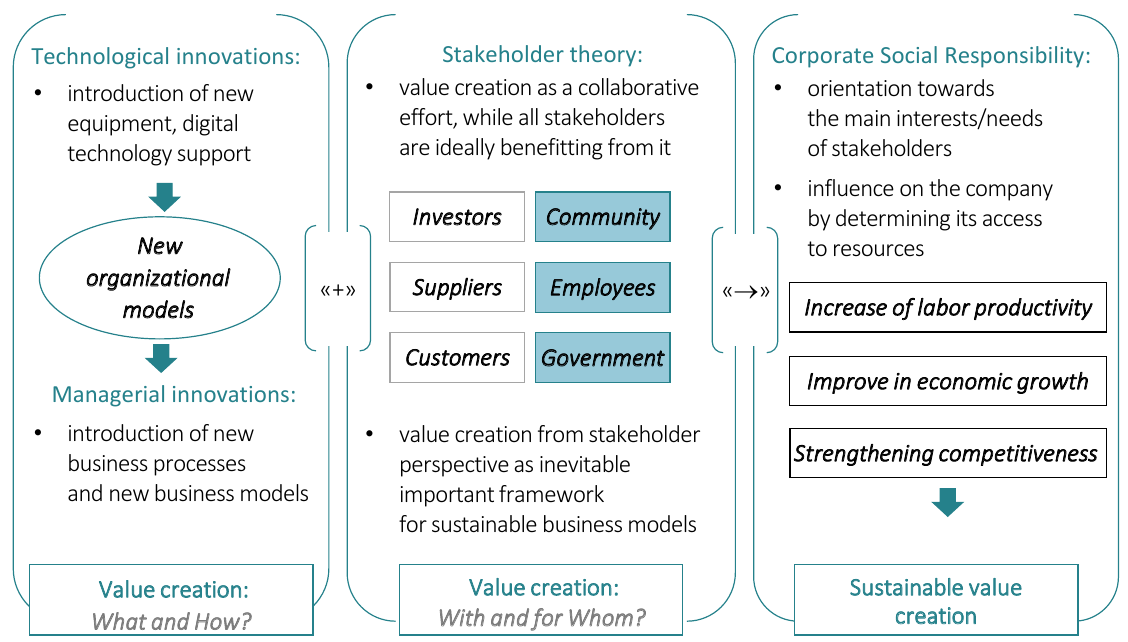
Figure 1. Linking integrated sustainable value creation, CSR, and stakeholder